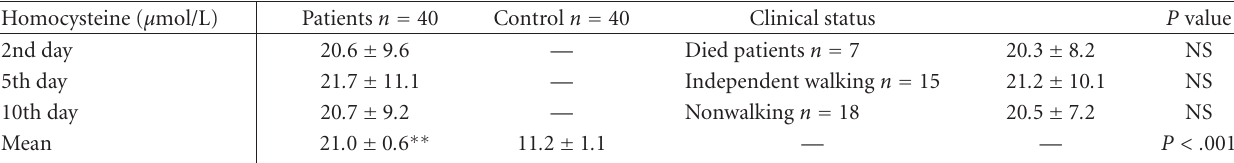
Table 3: Serum homocysteine levels of study and control groups (a)